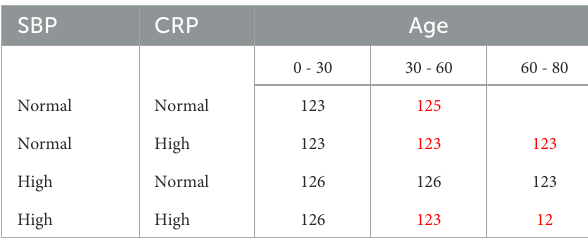
TABLE 4 A stratified treatment strategy based on age, SBP and